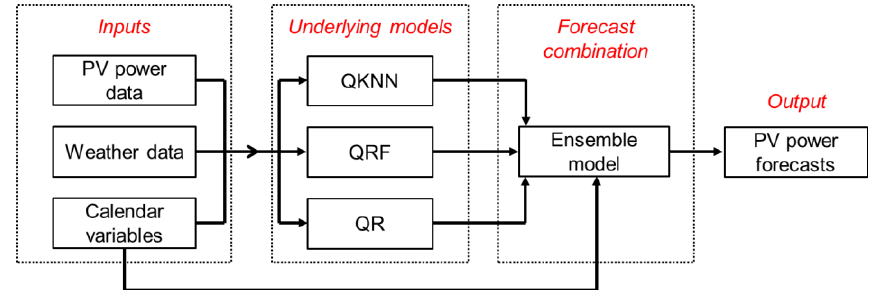
Figure 1. Overview of the proposed competitive ensemble method for forecasting photovoltaic (PV) power.